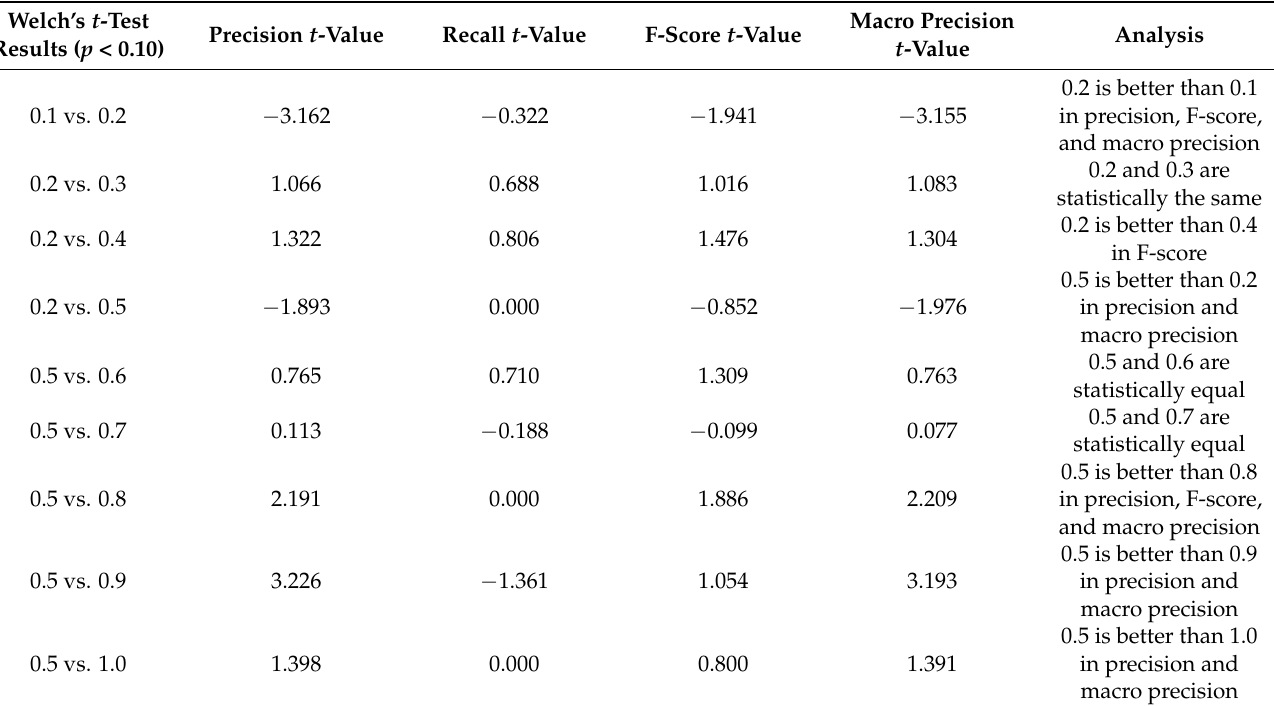
Table 12. Welch’s t -test results: UWF-ZeekData22: credential access—random undersampling before